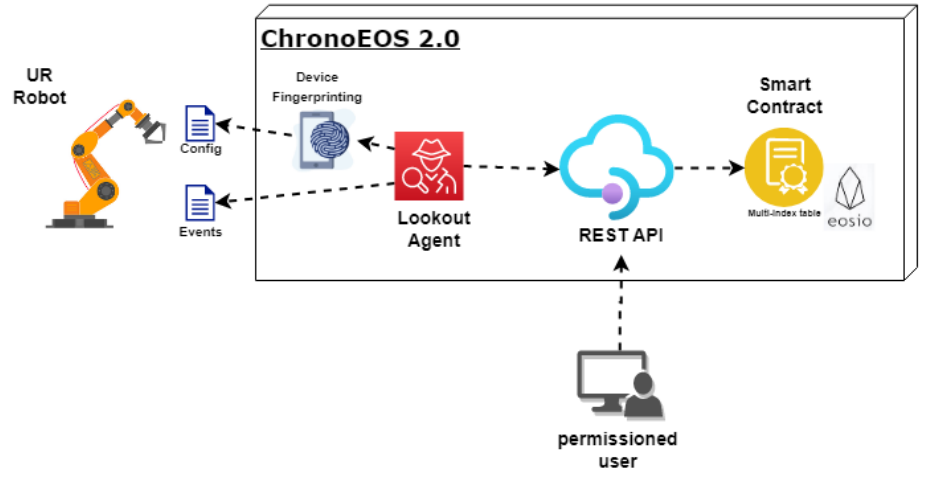
Figure 1. The diagram of ChronoEOS 2.0, considering the simplest scenario.